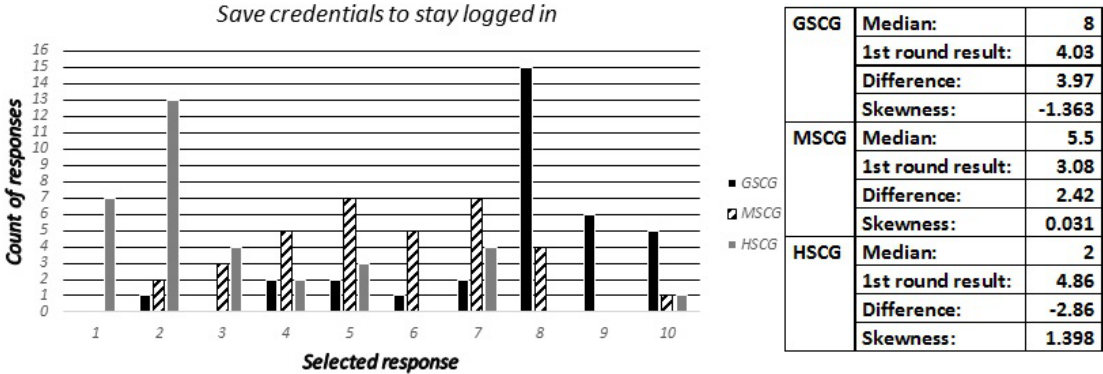
Figure 11. Expert predictions for question 9, “Save credentials to stay logged in”.